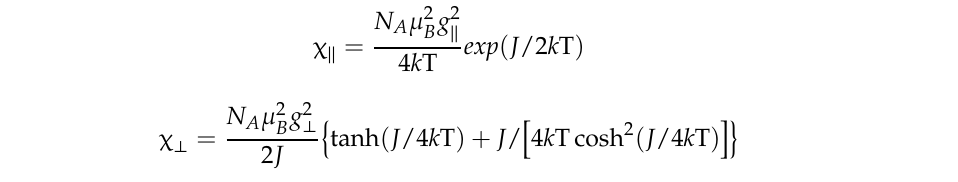
Figure 5. χ M T vs. T Plot for catena -[Co(µ 1,5 -dca) 2 (4-MOP–NO) 2 ] ( 1 ). The solid line shows the best fit obtained (see text).